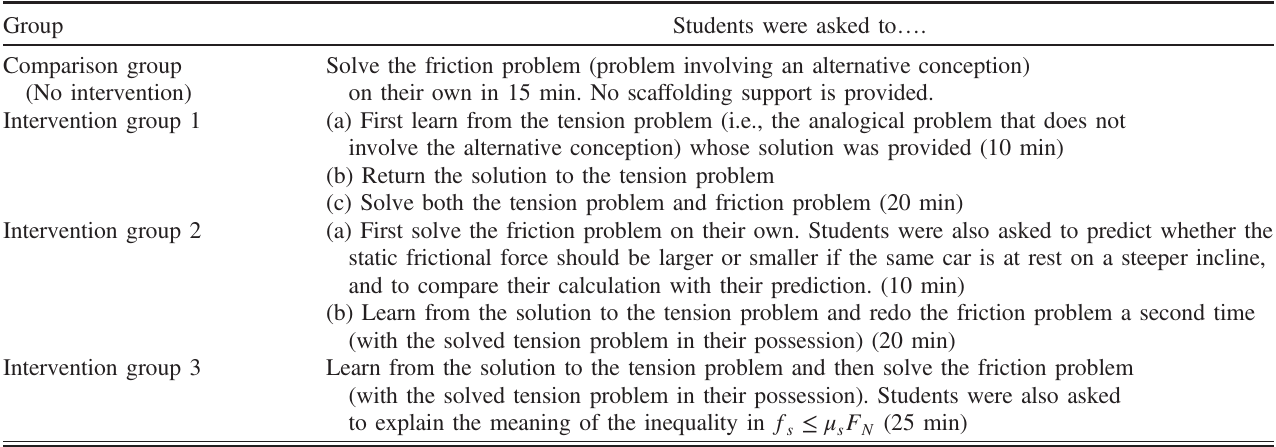
TABLE I. Summary of different interventions used in the study. The time a provided to students to complete each task is included in the parentheses. We note that students in all groups had enough time to complete the task. Group Students were asked to …